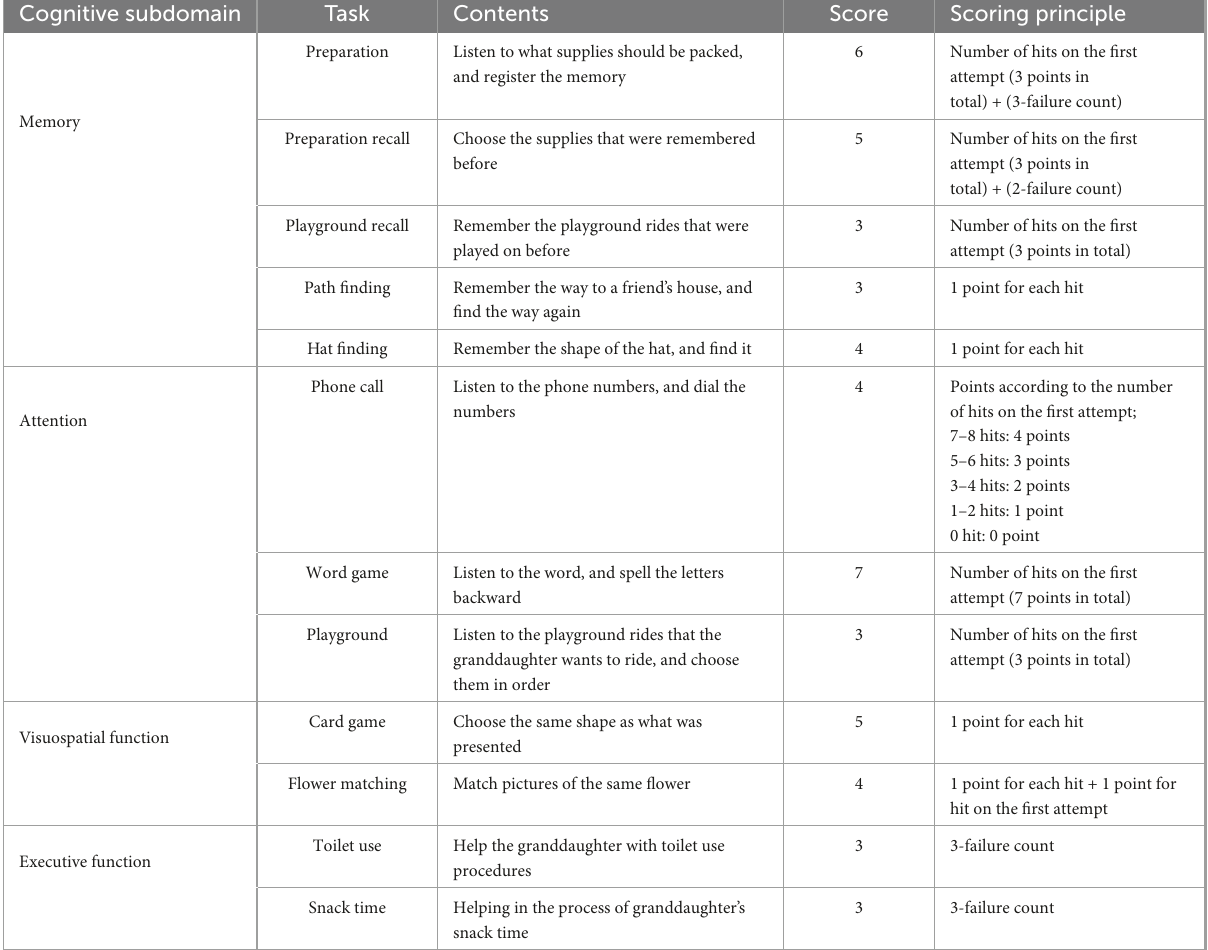
TABLE 2 Overview of virtual reality cognitive function test program. Cognitive